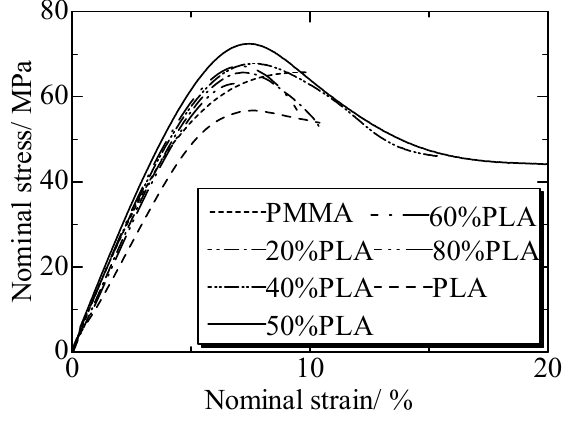
Figure 18. Tensile strengths of matrices and PLA/PMMA blends. Adapted from Reference [148].